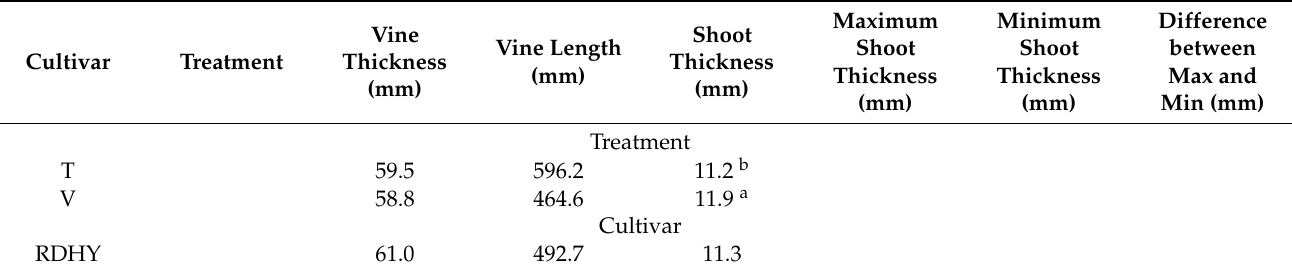
Table 2. Effects of trellis systems on the vine growth characteristics of the cultivars. Data are the mean of three replications. A two-way analysis of variance (ANOVA) was conducted (treatment × cultivar). Within the same column and factor, different letters stand for the signifi- cant difference ( p value < 0.05) according to the Student–Newman–Keuls test. Significant differences are indicated: ***, p value < 0.001, ns, not